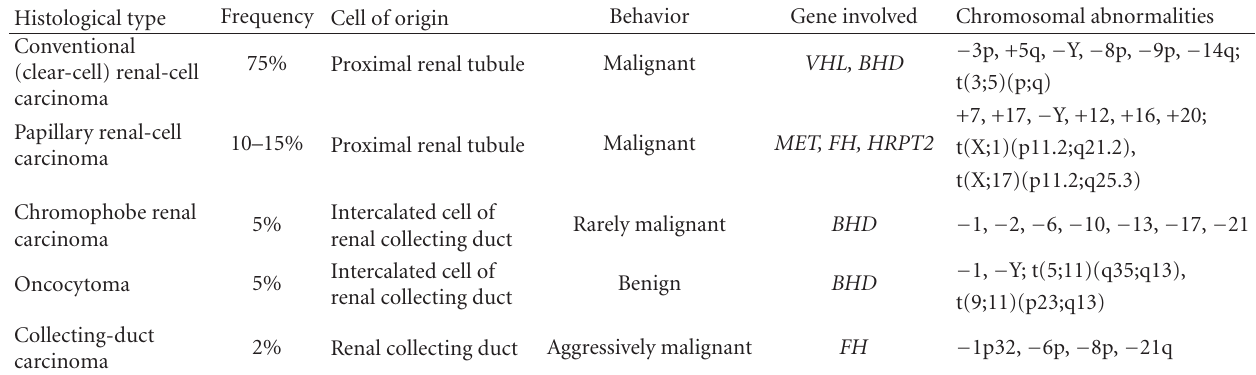
Table 1: Classification of renal epithelial tumors.